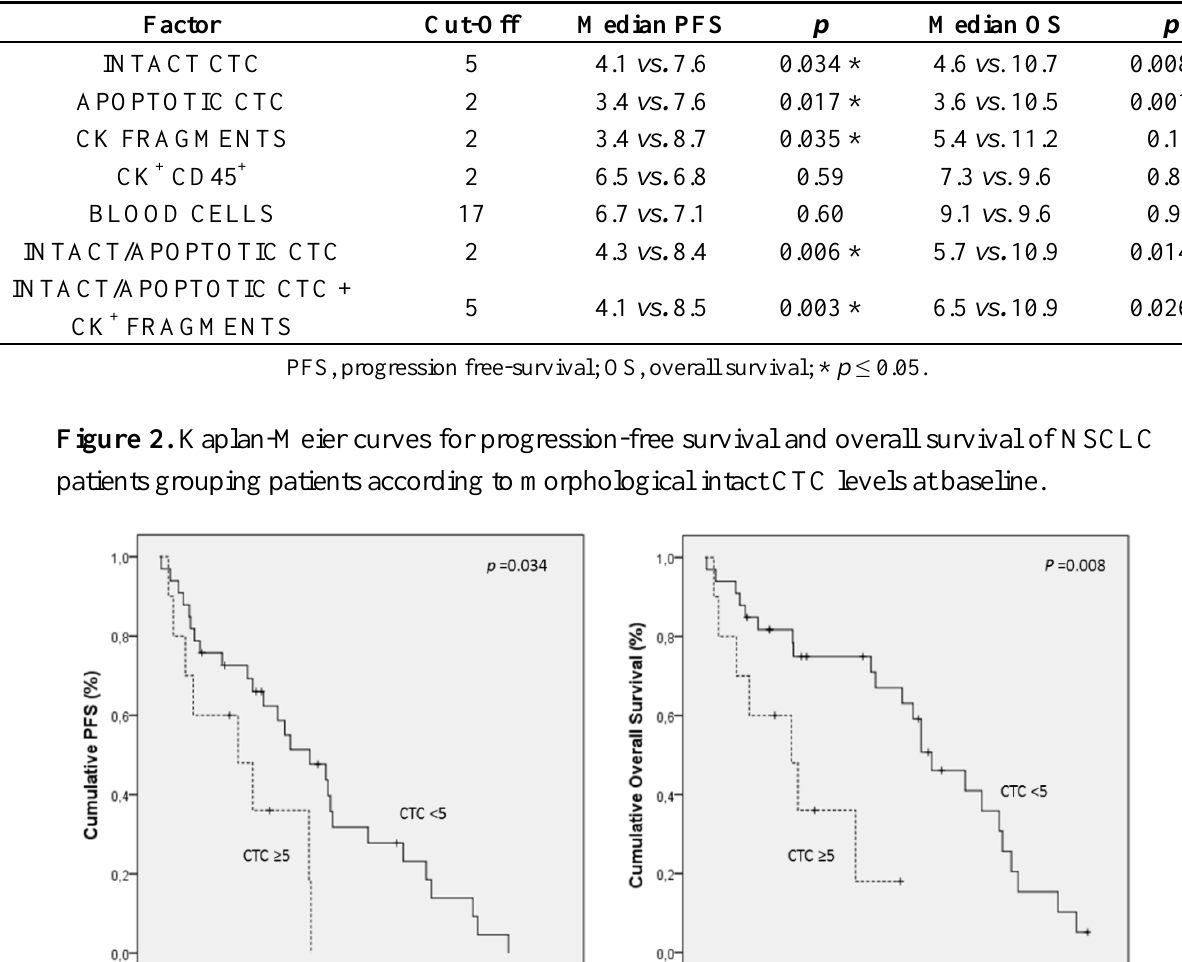
Table 3. Prognostic value of CTC and object levels at baseline.